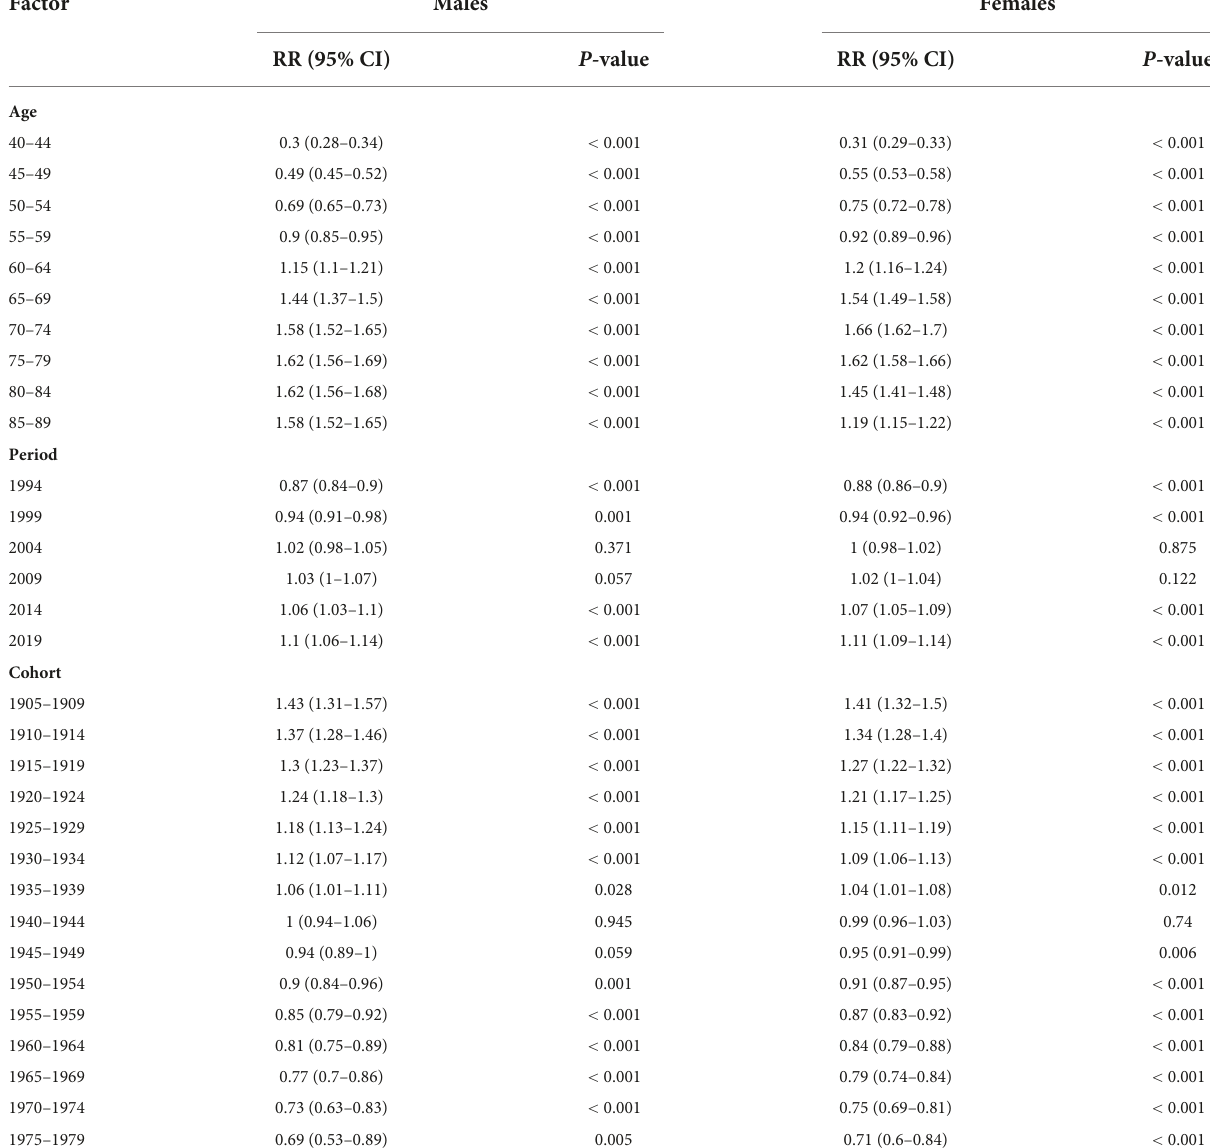
TABLE 2 Sex-specific relative risks of peripheral artery disease incidence in China due to age, period, and cohort effects.